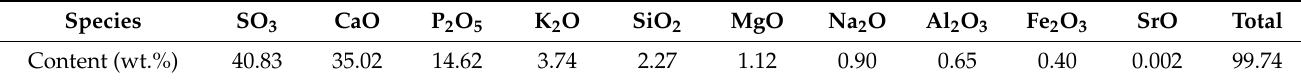
Table 2. Composition of the AMR